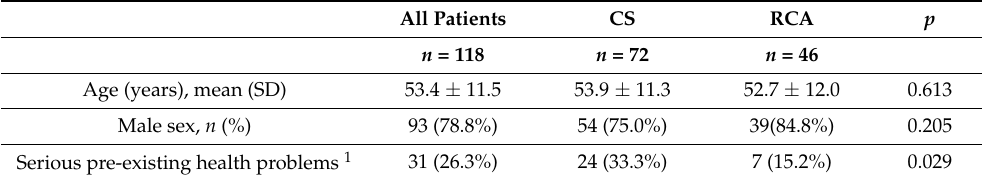
Table A1. Patient characteristics and comparison between CS and RCA patients. All